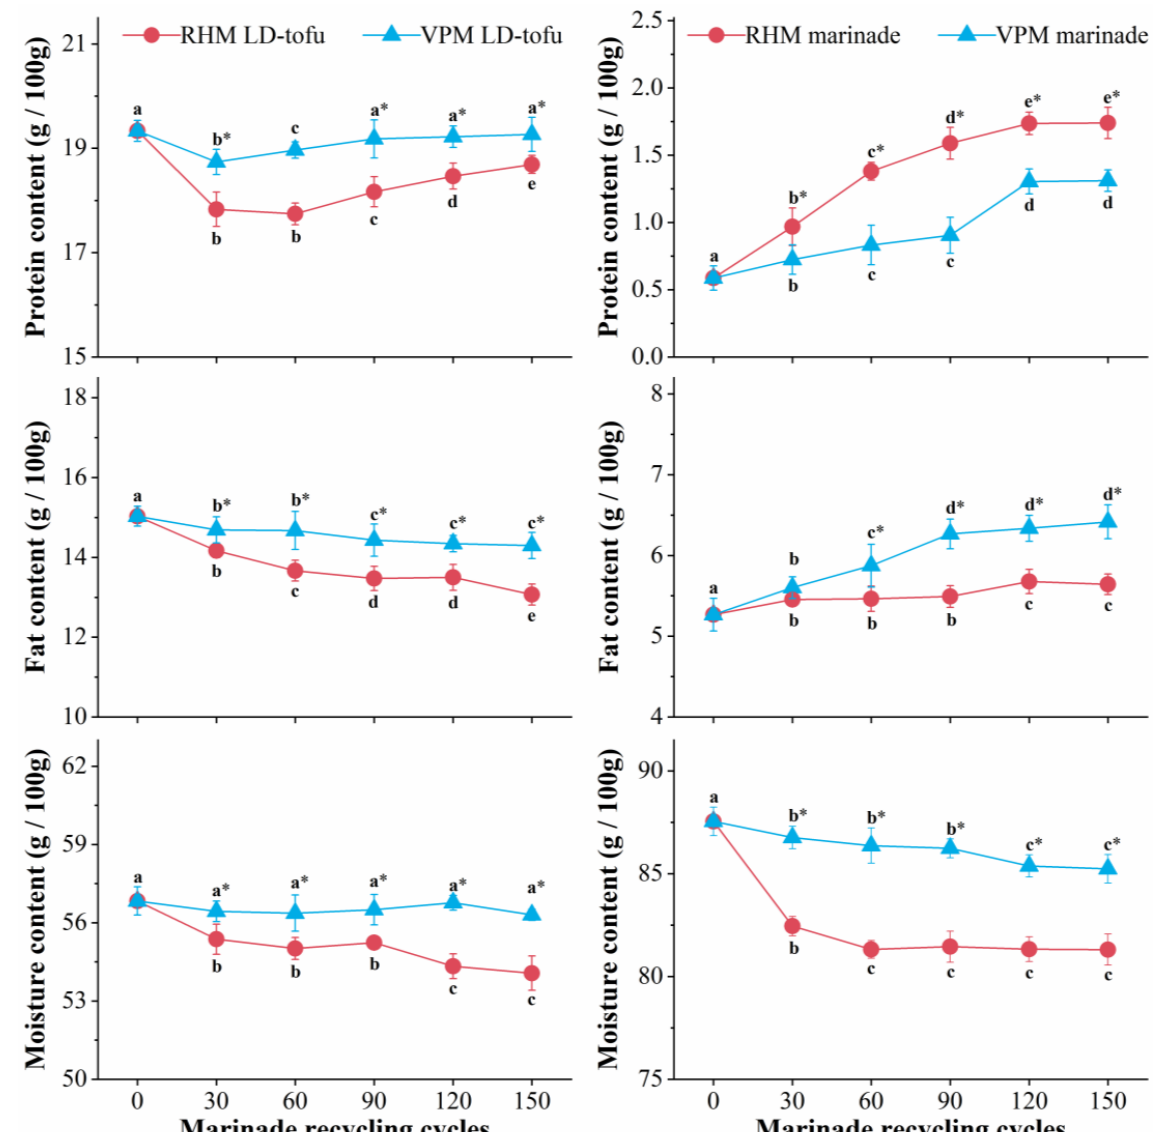
Figure 2. Effects of marinating method and marinade recycling cycles on the basic nutrients of LD-tofu and marinade. Superscripts with different letters in a row are significantly different between groups ( p < 0.05). * indicates a significant difference between RHM groups and VPM groups ( p < 0.05).